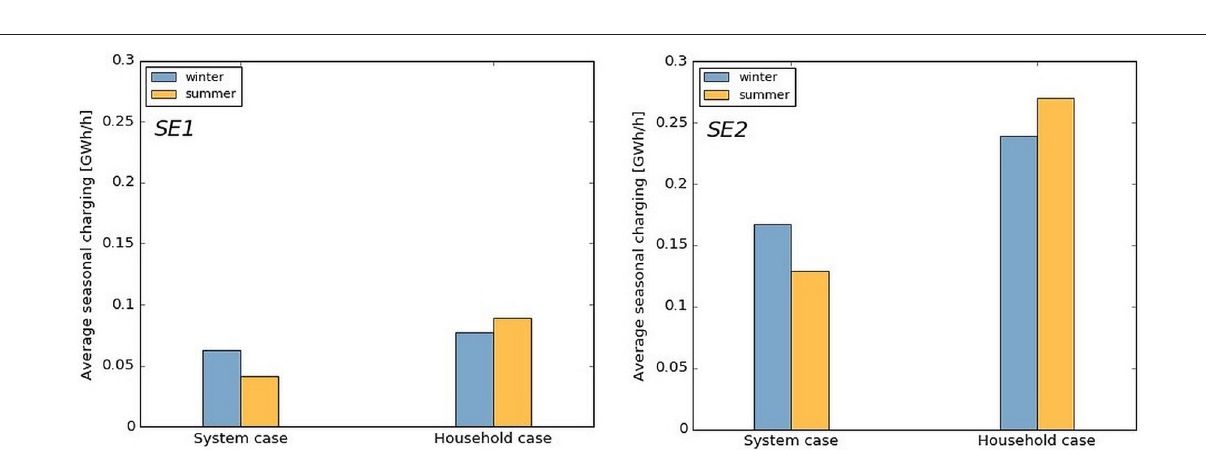
FIGURE 9 | Average seasonal charging per hour for the System and Household cases in regions SE1 and SE2, as obtained from the modeling of the Green Policy scenario in Year